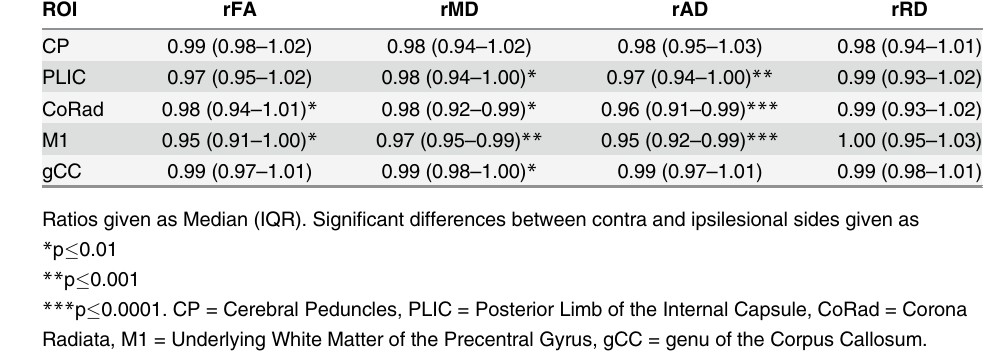
Table 2. Ratios of diffusion metrics in the four Regions-Of-Interest and control region. ROI rFA rMD rAD rRD CP